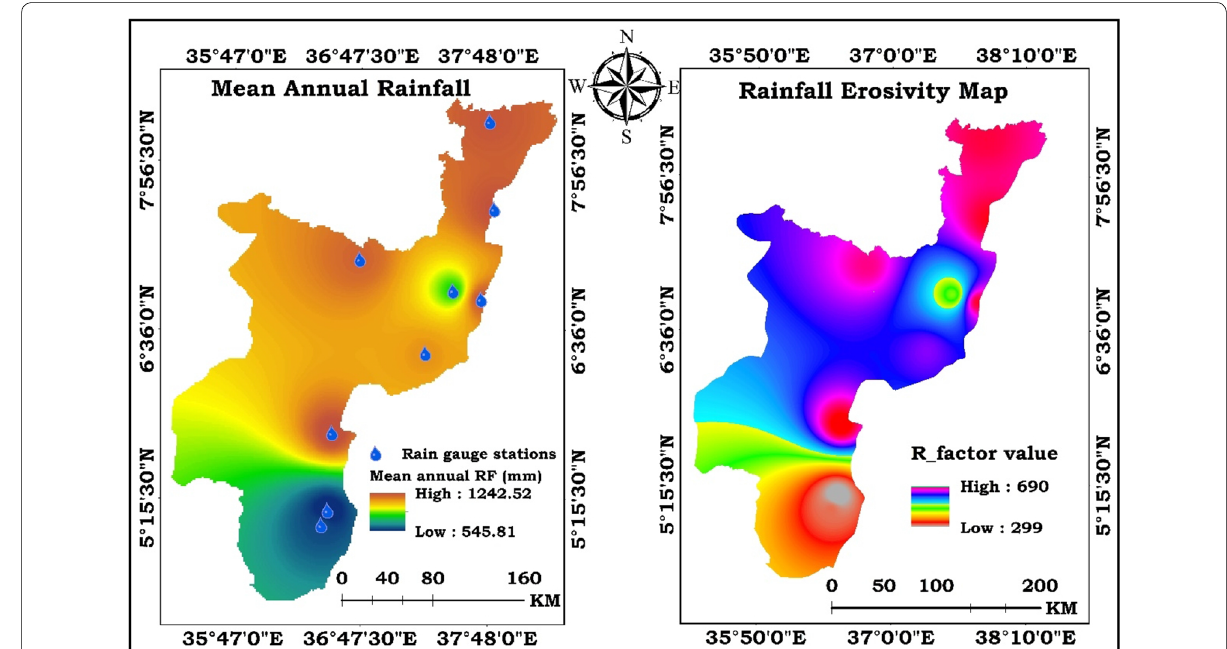
Fig. 3 Mean annual rainfall and R-factor